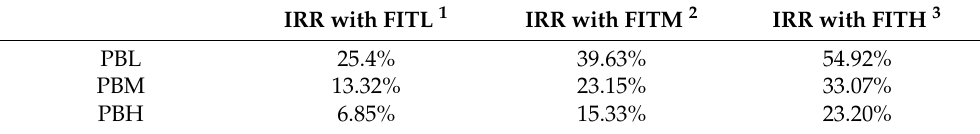
Table 7. Internal rate of return based on historical Parsons Brinckerhoff figures (as available in [68]), electricity production only (CHP-E